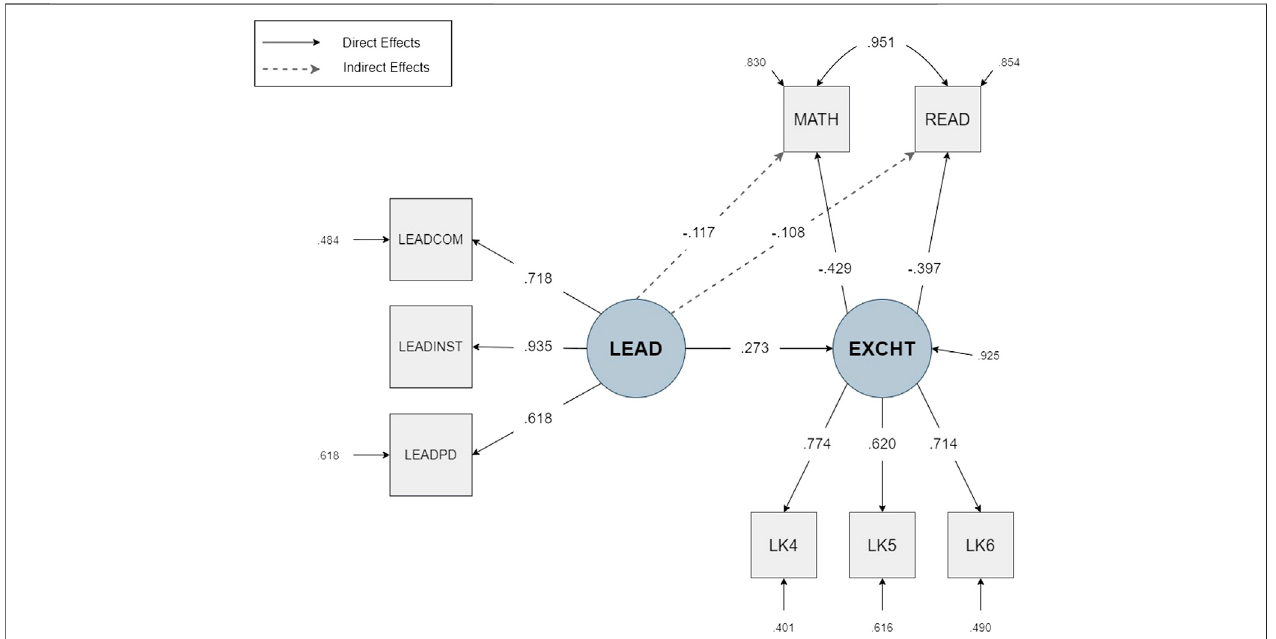
FIGURE4 | Structural model (at school level) ofinstructional leadership (LEAD), teacher collaboration (EXCHT) and studentachievement (MATH and READ). Note: All displayed values signi fi cant at p ≤ 0.05.